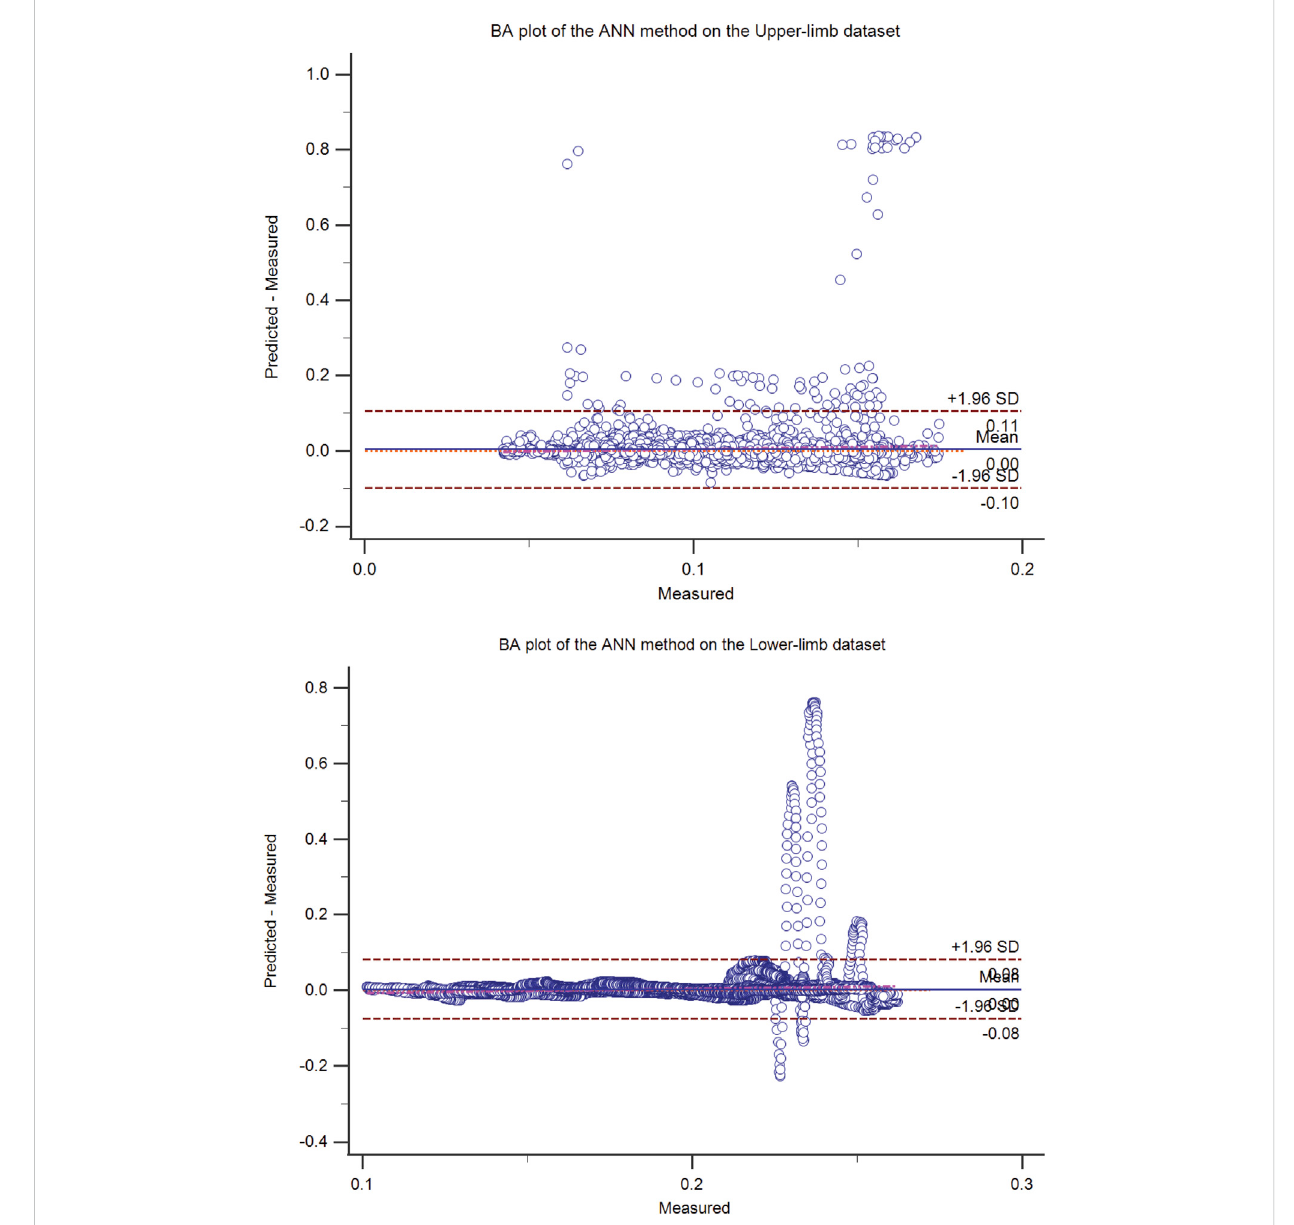
FIGURE 1 The Bland-Altman (BA) plot of the ANN method on the upper-limb (top) and the lower-limb (bottom) test dataset (50% hold-out validation). The BA plot shows the scatter plot of the residual signal (predicted force minus measured force signal) (y-axis) and the measured force signal (x-axis), which identi fi esthe homogeneity ofthe residual signal at different measured signal levels. In addition to themean residual signal (i.e., bias), the upper and lower boundaries (mean (residual signal) ± SD (residual signal)) are also